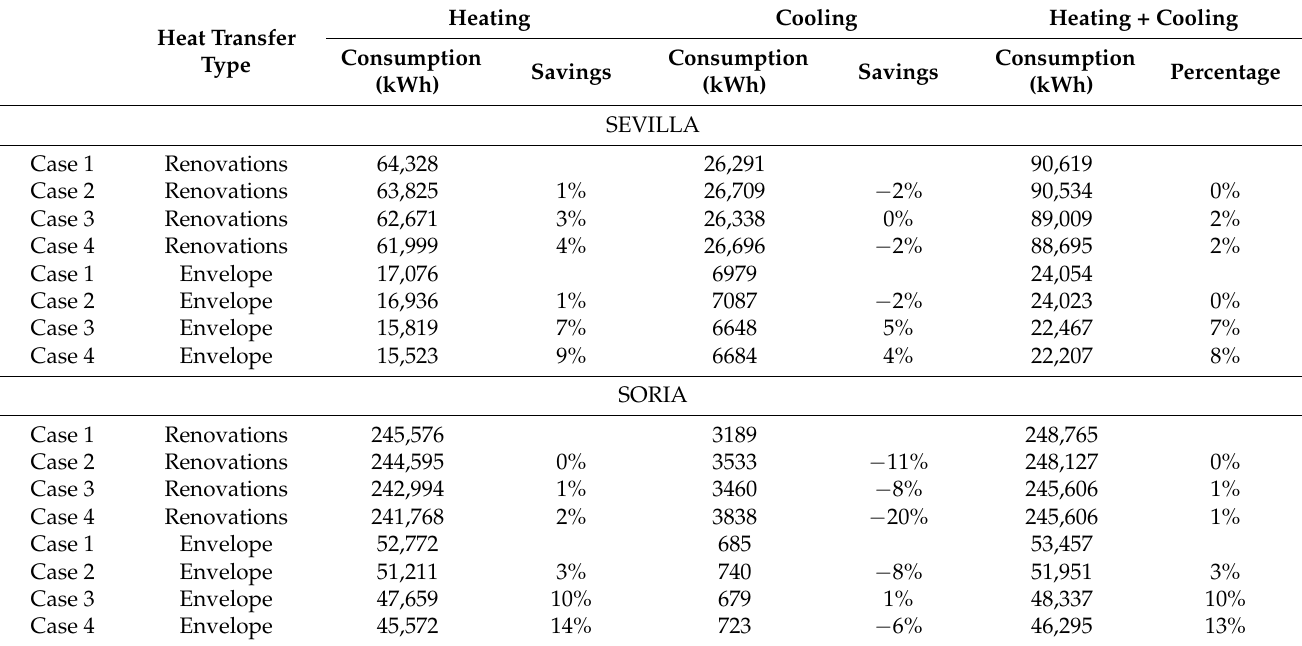
Table 6. Energy consumption of the building due to the heat transfer of air renewals and through the envelope of the building located in Seville and